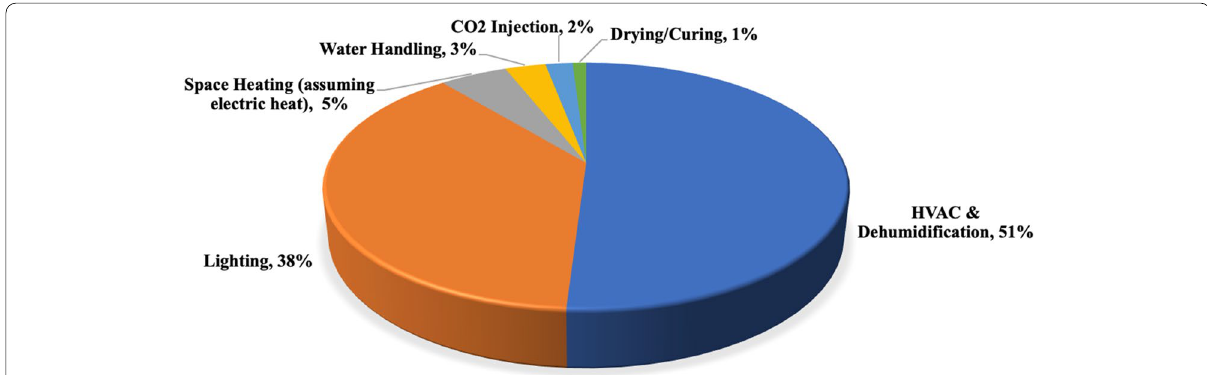
Fig. 1 End-use electricity consumption